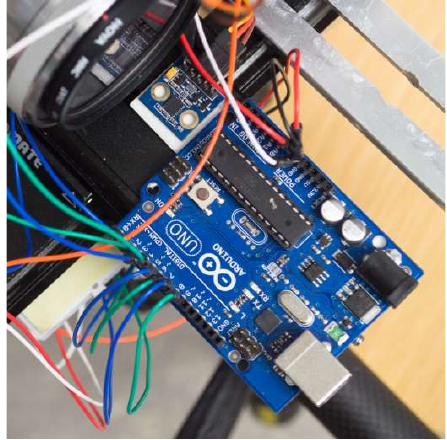
Figure 3. The structural image of the motorized panoramic mount.